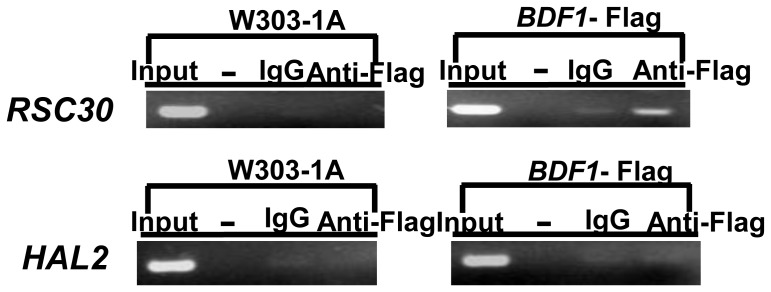
Bdf1p regulated HAL2 expression indirectly.The anti-Flag antibody was used for Bdf1p precipitation and IgG was used as a negative control. The promoter regions probed by ChIP correspond to nucleotides −200 to −1. Error bars denote standard deviation (SD). *P<0.05, **P<0.01 vs. wild type under the same treatment, n = 3.